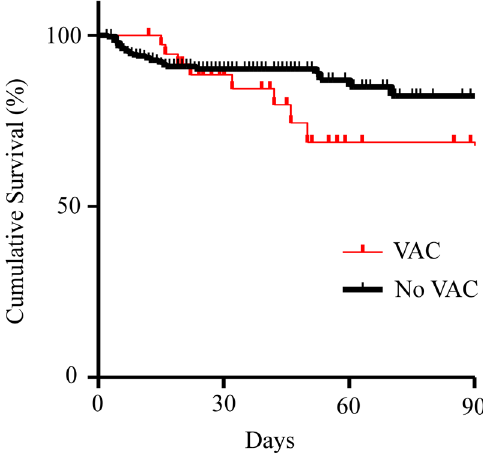
Fig 2. Kaplan – Meier analysis of cumulative